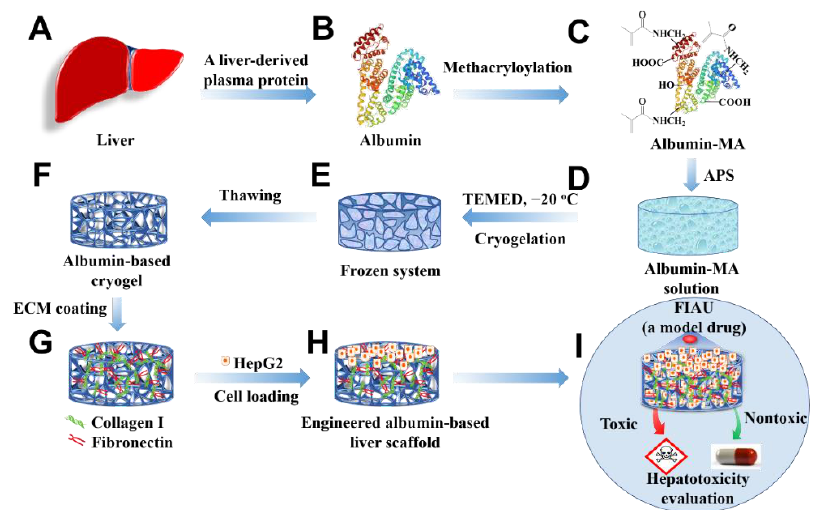
Figure 1. Schematic illustration presenting the fabrication of an engineered albumin-based liver scaffold for hepatotoxicity evaluation. ( A ) Liver. ( B ) Liver-derived albumin. ( C ) Albumin-MA was obtained via the methacryloylation. ( D ) Albumin-MA solution with an initiator, APS. ( E ) Cryogelation with a catalyzer (TEMED ) under −20 °C. ( F ) Albumin-based cryogels after thawing. ( G ) ECM-coated albumin-based cryogels. ( H ) Cell-laden albumin-based cryogel liver constructs. ( I ) Hepatotoxicity evaluation.